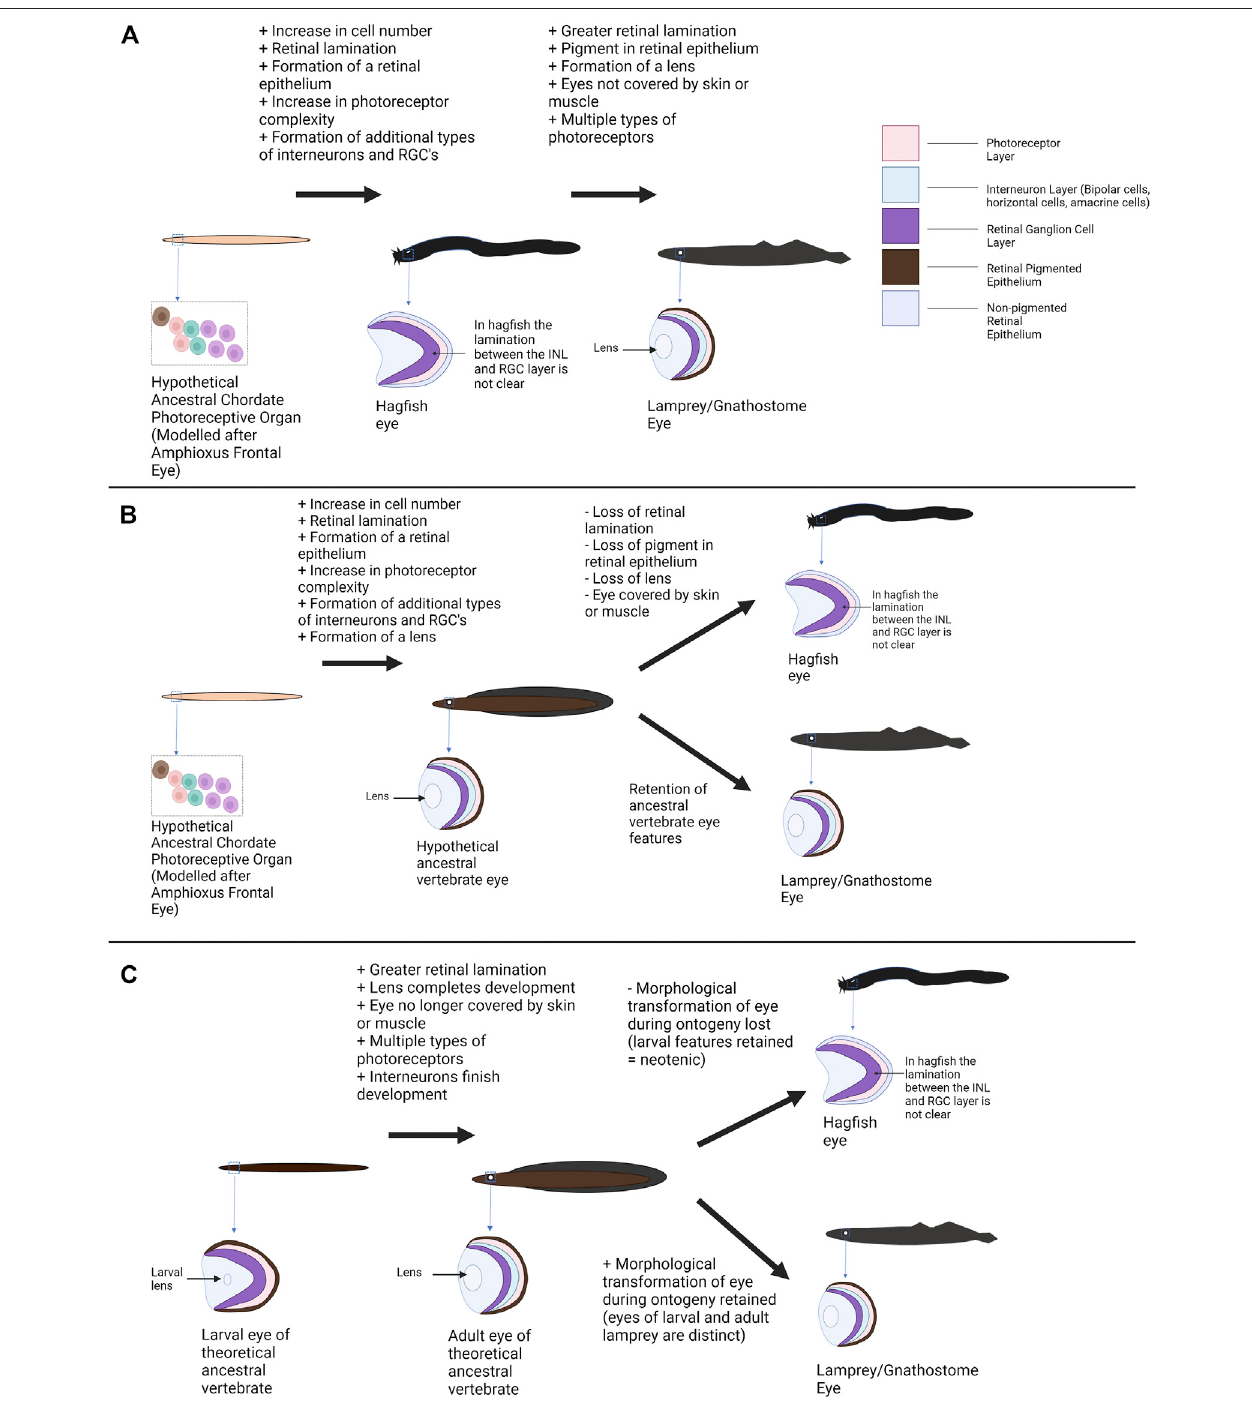
FIGURE 4 | Alternative models of vertebrate eye evolution. (A) Hag fi sh eye as an ancestral state of the vertebrate eye. In this scenario the extant hag fi sh eye is representative of the ancestral vertebrate eye state (this “ primitive ” eye still has greater complexity than the photoreceptive structures of non-vertebrate chordates). The lamprey converged upon a more complex eye condition alongside the gnathostomes. (B) The hag fi sh eye as degenerate/regressed. In this scenario the last common ancestor of cyclostomes and gnathostomes has a relatively sophisticated eye. The lamprey and lineage leading to gnathostomes maintained this eye condition whereasthe hag fi sh eyeconditions degenerated resultingin extant hag fi sh possessingrudimentaryvisual structures. (C) The hag fi sh eyeaspaedomorphic/neotenic. In this hypothesis, the last common ancestor of gnathostomes and cyclostomes would have undergone a shift in eye morphology during ontogeny with larvae have more rudimentary features and adults having complex eyes.Lamprey (and gnathostomes)maintained thisshiftto amore complex state. The hag fi sh nolongercompletes this transition and the eye seen in adult hag fi sh represents “ juvenile ” vertebrate eye features. A mixture of these scenarios may have occurred (see Section 3 — Discussion). Graphics created using